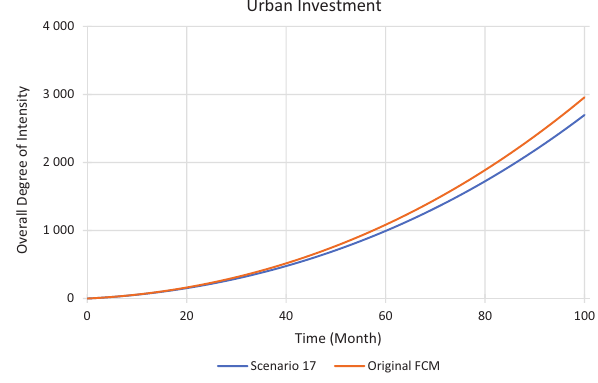
Figure 8. Impact of scenario 17 on urban